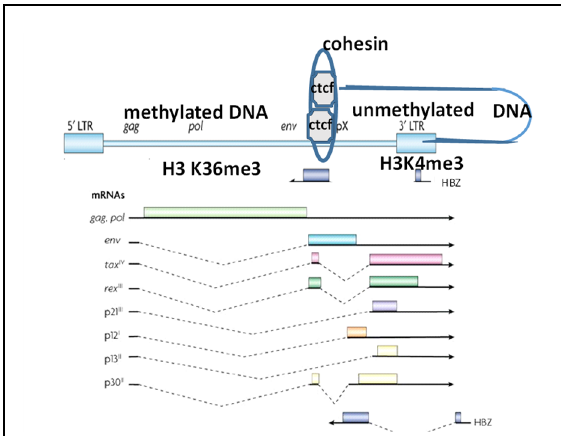
Figure 1. Schematic diagram of the HTLV-1 provirus, CTCF-BS, epigenetic modifications, and tran- scripts. The top figure shows potential looping of the HTLV-1 CTCF-BS with a cellular CTCF-BS, with bound cohesin. The epigenetic barrier created by CTCF results in 5 ′ provirus methylated DNA and 3 ′ provirus unmethylated DNA as well histone marks of inactive and active chromatin, respec- tively.